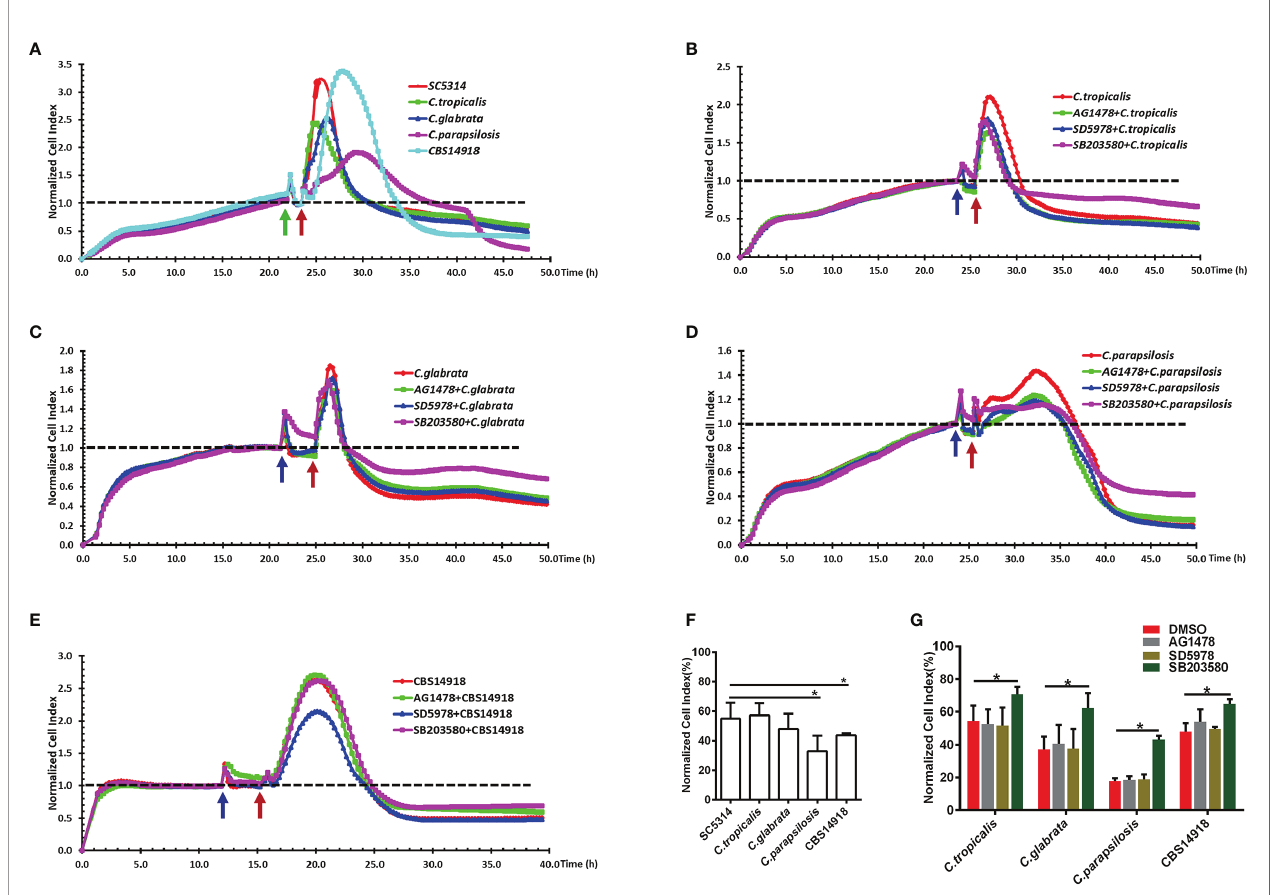
FIGURE 6 | EGFR and MAPK signaling regulate the viability of vaginal epithelial cells after infection with non-albicans Candida species. Cells damage caused by SC5314 and non-albicans Candida (NAC) isolates were monitored continuously for 24 h (A) . Only pre-treatment of p38 inhibitor (SB203580) exhibited a signi fi cant increased protective capacity against NAC isolates compared to EGFR and ERK1/2 inhibitor (B – E) . NCI at 24 h post infection in graph (F, G) provides the mean cell viability. Green arrow represents the time points at which the medium was changed. Blue and red arrows represent the time point on which inhibitors and Candida strains were added into the well respectively. Data are representative of three independent experiments. Error bars represent SD, *p <